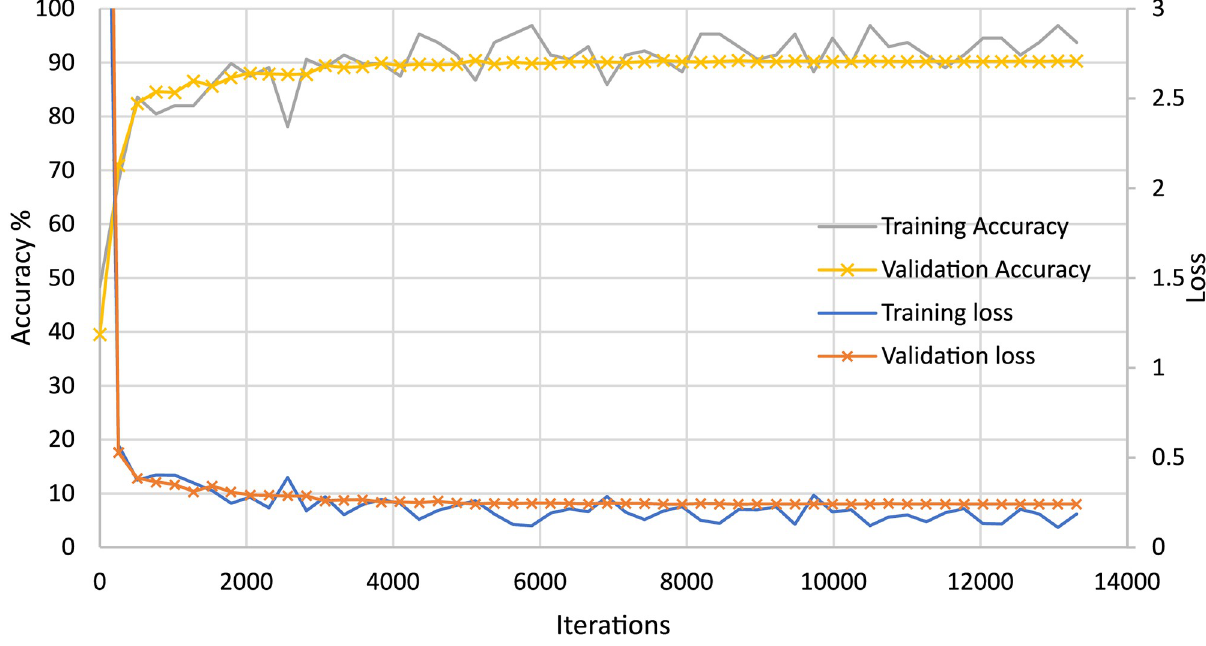
Fig 10. Accuracy-loss graph of the proposed CNN (for the lowest-performing